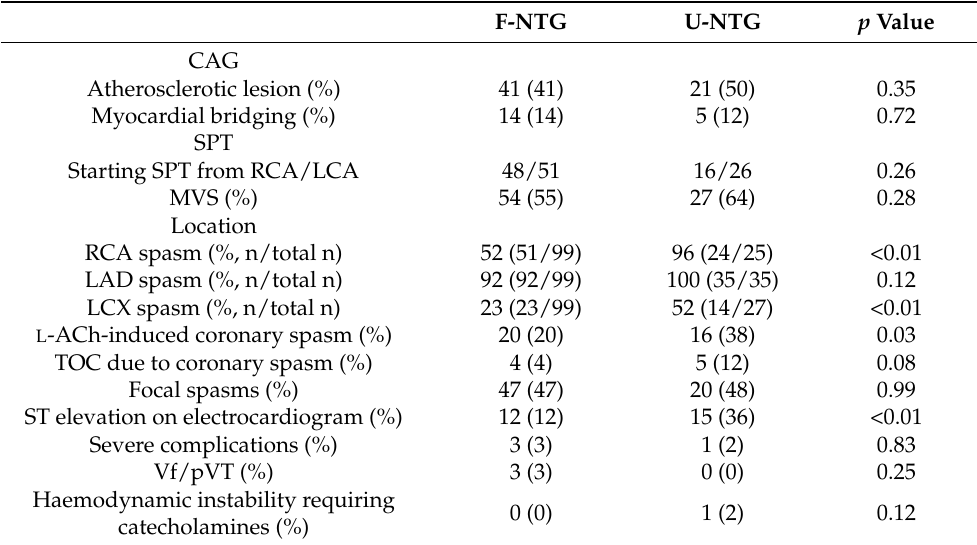
Table 4. The results of CAG and SPT.